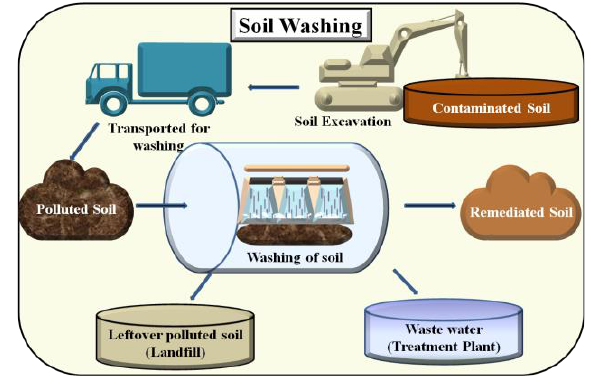
Figure 2. The ex situ washing the